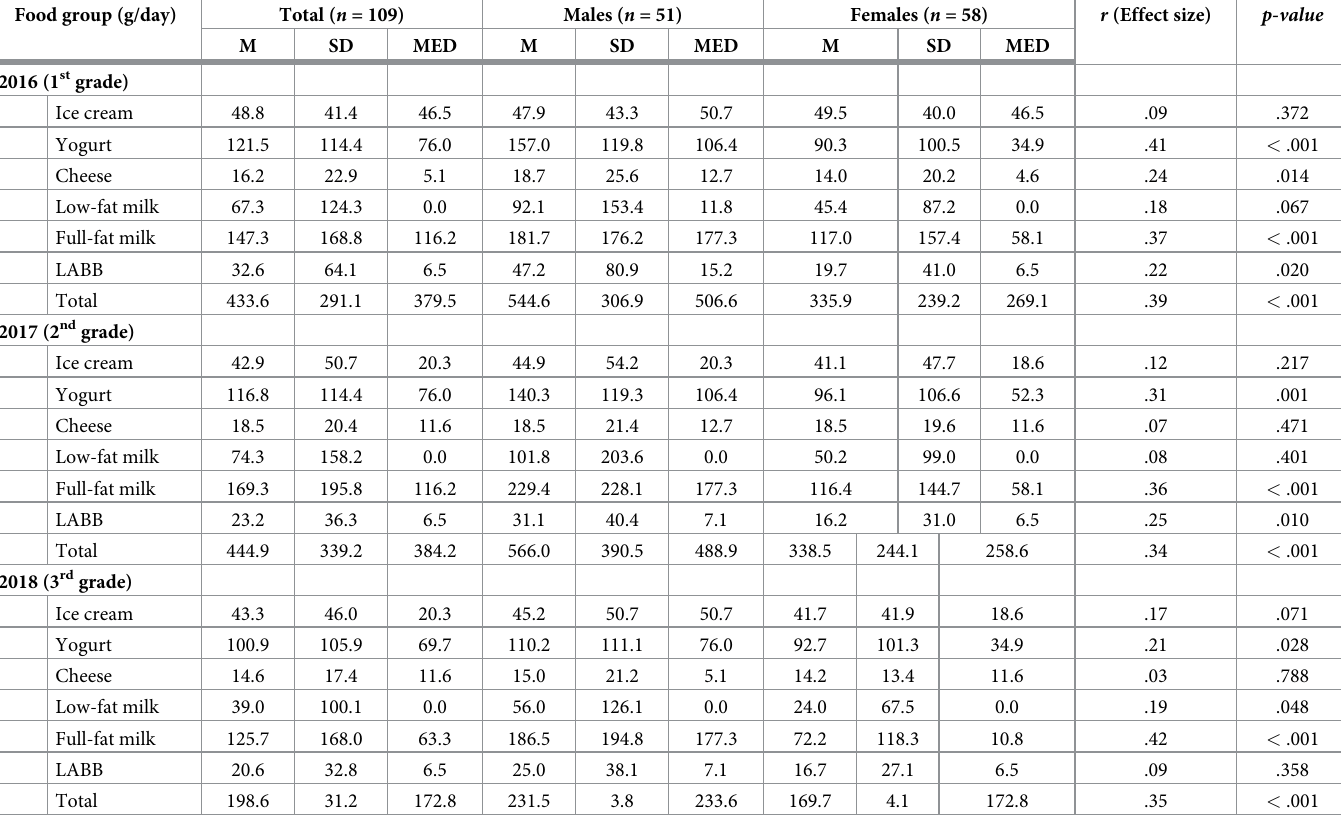
Table 4. Means, standard deviations, and medians for dairy product intake and the results of the U -test by sex. Food group (g/day) Total ( n = 109) 2016 (1 st grade) Yogurt Cheese